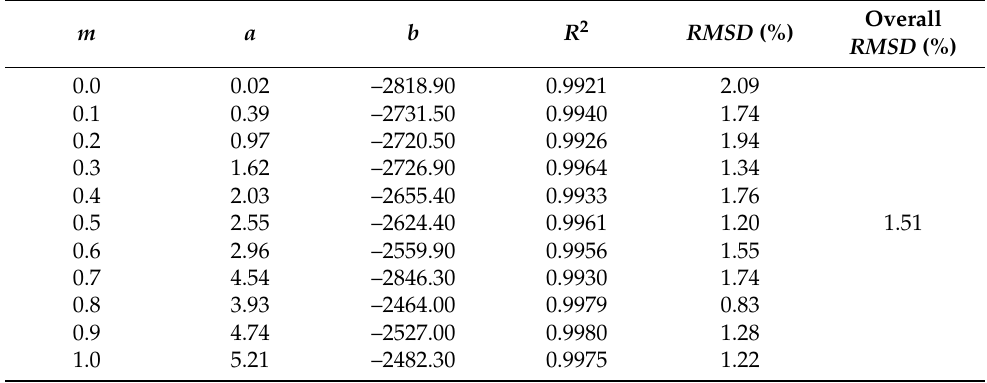
Table 5. Resulting data of van’t Hoff model for TQ in binary (IPA + H 2 O) compositions ( m ).